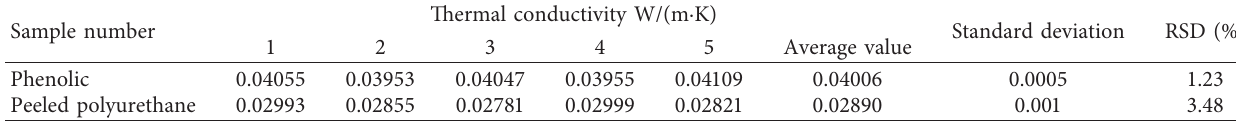
Table 9: Testing parameters determined using the Hot Disk